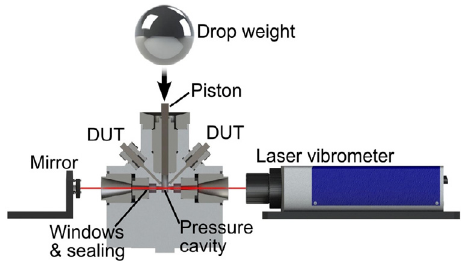
Fig. 9. Design of the PTB pressure